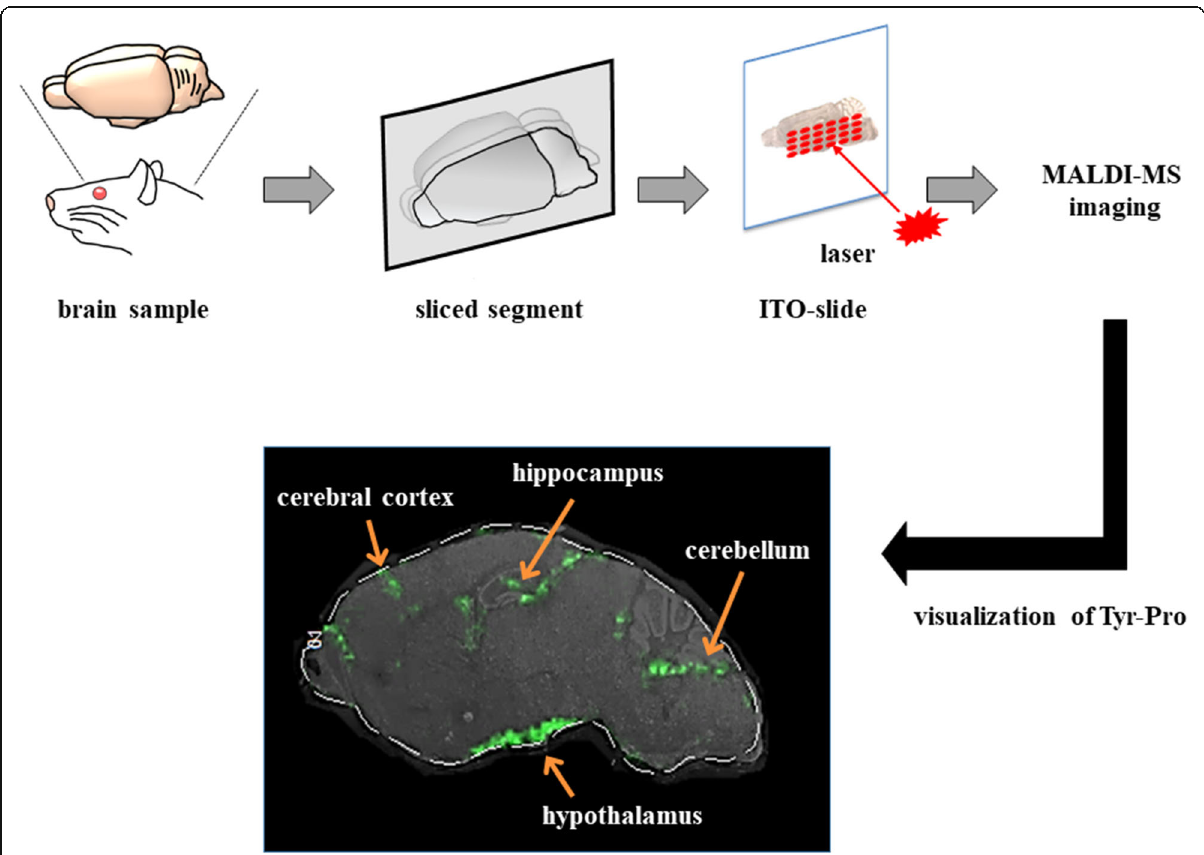
Fig. 4 Visualized distribution of Tyr-Pro in perfused mouse brain by MALDI-MS imaging. MALDI-MS/MS images of Tyr-Pro ([M + H] + , 279.1 > 116.0 m/z ) display the sagittal tissue and coronal sections of 10-min Tyr-Pro-perfused mouse brain. Scale bar, 2 mm; spatial resolution, 90 μ